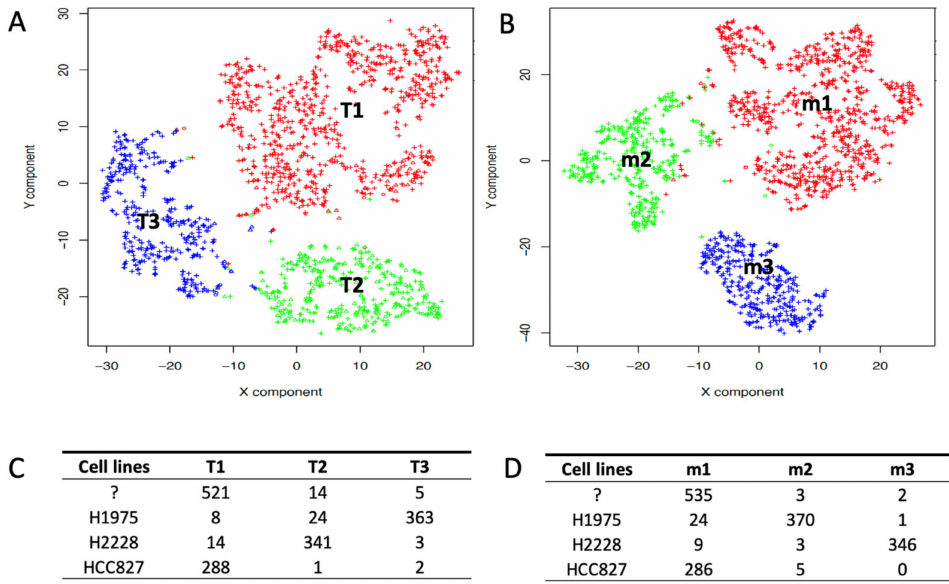
Figure 6. RNA-3c, clustering of cells using the SCA meta-genes. ( A ) SCA using TFs targets, ( B ) SCA using miRNA targets, ( C ) clusters to cell association for A, ( D ) clusters to cell association for